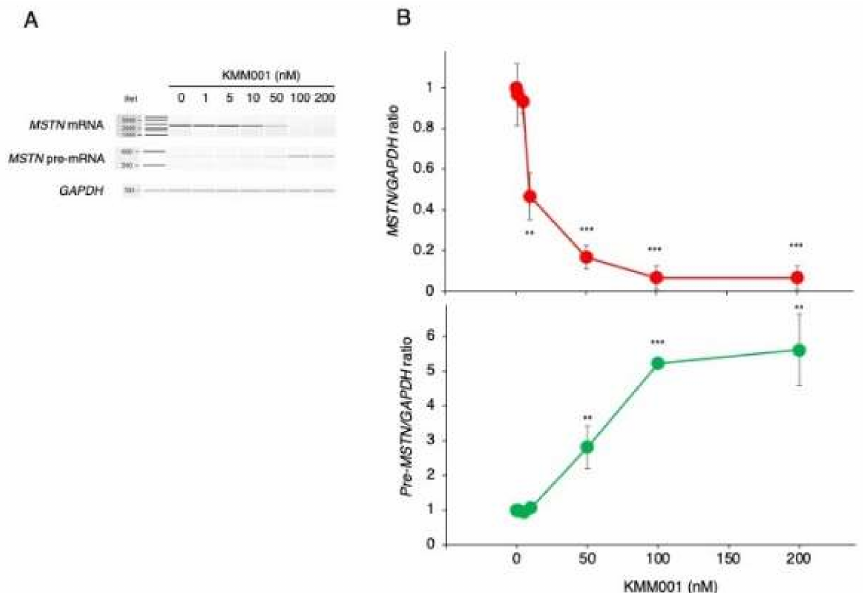
Figure 5. Dose-dependent action of KMM001 on splicing of the MSTN gene. ( A ) KMM001 was added to the culture medium of CRL-2061 cells at the indicated concentrations, and the cells were cultured for 1 day. Fragments of exons 1 to 3 and intron 2 to exon 3 of MSTN pre-mRNA were RT–PCR amplified. Electrophoretograms of the PCR products are shown. ( B ). The MSTN/GAPDH ratio was calculated for each designated concentration after semiquantification of the amplified products using an Agilent Bioanalyzer. The ratio plotted against the concentration of KMM001 is shown ( upper ). The ratio decreased dose dependently from 0 to 100 nM KMM001 and reached its lowest value at 100 nM. Next, the pre- MSTN/GAPDH ratio was calculated for each designated concentration. The ratio plotted against the concentration of KMM001 is shown ( lower ). The ratio increased dose dependently from 0 to 100 nM KMM001 and reached a plateau at 100 nM. ** = p < 0.01, *** = p < 0.001 vs. 0 nM KMM001.